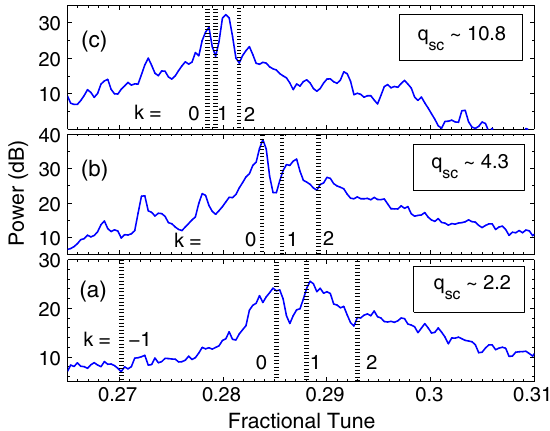
FIG. 10. Vertical tune spectra for N 7 þ ions and beam parame- ters given in Table II. The dashed lines indicate the head-tail tune shifts from Eq. (8).